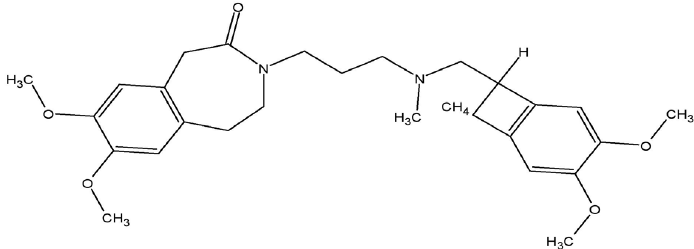
Figure 1. Molecular structure of ivabradine.